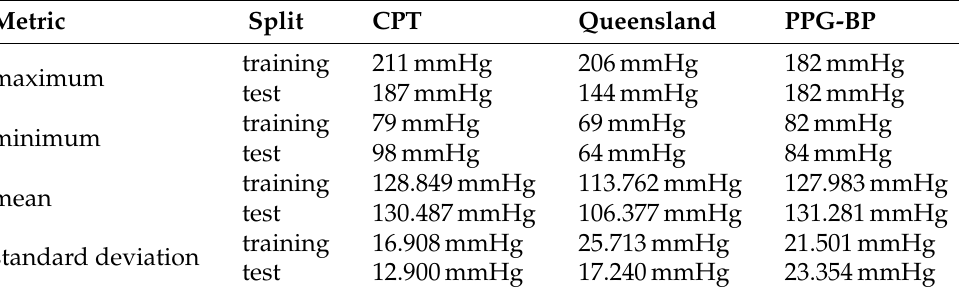
Table 4. BP characteristics for the test and training set of the single datasets